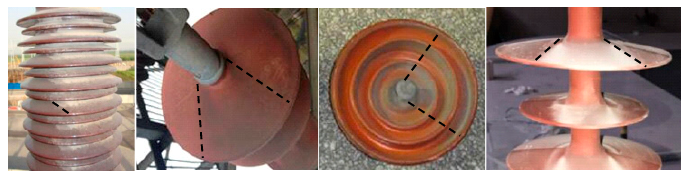
Figure 1. Non-uniform pollution between windward and leeward sides on insulator surface.